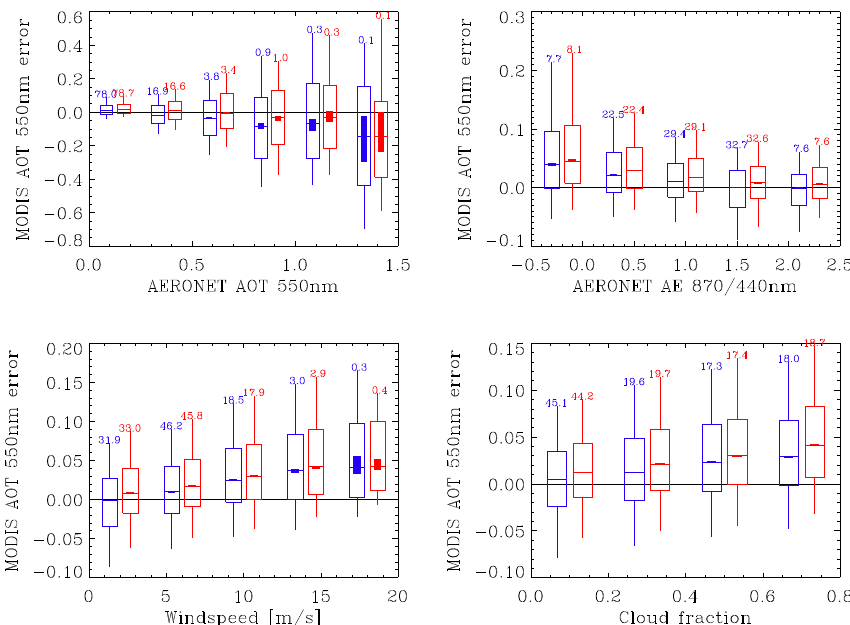
Fig. 3. MODIS AOT error statistics as a function of AERONET AOT, AERONET AE, NCEP-DOE-II wind speed and MODIS cloud fraction (blue: Aqua; red: Terra). The box–whisker plots are offset from these bin centres to show the two distributions side by side. Numbers above the box and whisker show the percentage of the total sample used in that